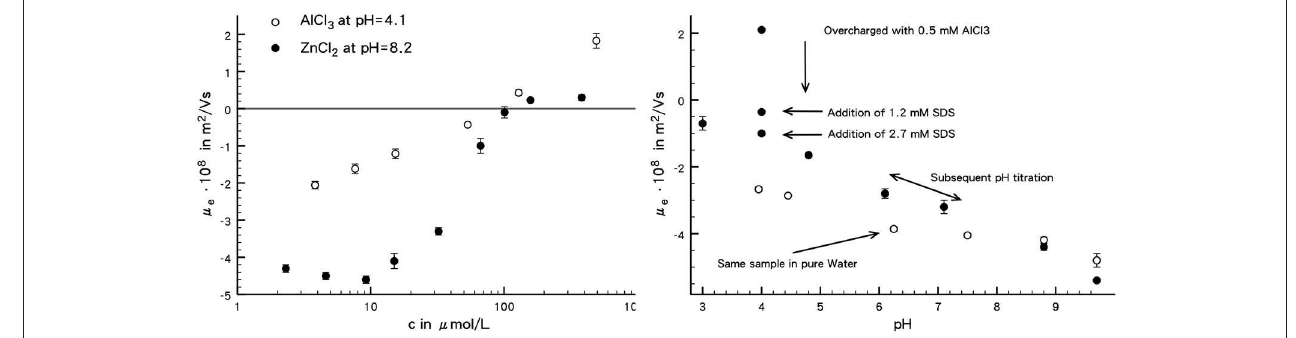
FIGURE 3 | (Left) electrophoretic mobility of SFP-30M as a function of AlCl 3 at pH = 4.1 and ZnCl 2 at pH = 8.2. (Right) electrophoretic mobility of SFP-30M in pure water (open circles) and of the same sample at pH = 4 (full circles), overcharged with 0.5 mM AlCl 3 . To this sample SDS was added with a subsequent pH titration. See text for detailed explanation. The error bars represent the standard deviation from three